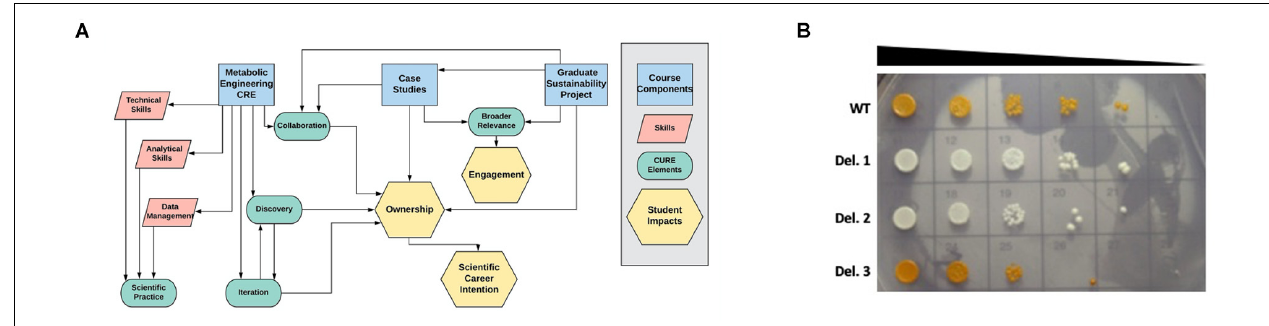
FIGURE 1 | Course design and example student data. (A) The three main components of the Yeast Metabolic Engineering course (blue rectangles) were designed to train students in specific skills (pink parallelograms) while incorporating the five elements of course-based undergraduate research experiences (green ovals), leading to the student impacts of engagement, ownership, and scientific career intention (yellow hexagons). (B) Students performed VEGAS to assemble the beta-carotene biosynthetic pathway in wild type (WT) yeast or a pool of barcoded single gene deletion strains. Transformants displaying decreased beta-carotene production (white colonies) or increased beta-carotene production (dark orange colonies) were selected for spot plate analysis to compare genetic fitness and barcode sequencing to identify the deleted genes. In some cases, these experiments resulted in novel findings. Deletion strain 3 (Del. 3) in this student experiment displayed increased accumulation of beta-carotene, and barcode sequencing identified this strain as an Mcr1 deletion mutant. This finding suggests that interfering with competing pathways, such as the ergosterol biosynthetic pathway, can drive increased beta-carotene